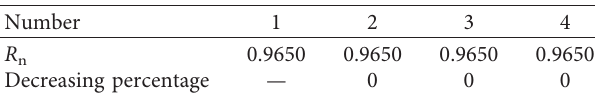
Figure 11: Effect of number of boreholes on the skin friction of the existing foundation Table 5: Effect of number of boreholes on the end resistance of the existing foundation pile.